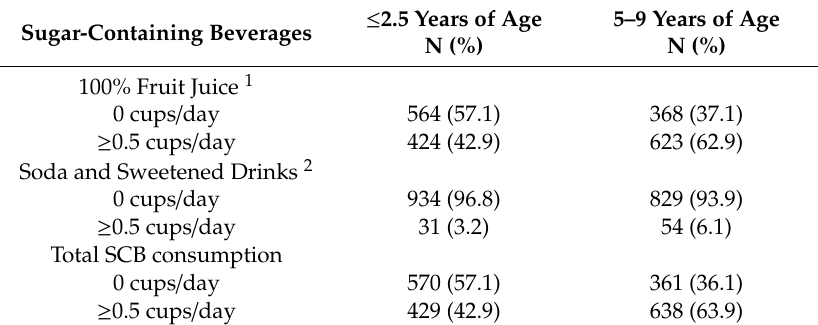
Table 2. Distribution of sugar-containing beverage consumption in children at ≤ 2.5 years of age and 5–9 years of age among children in TARGet Kids! in Ontario, Canada ( n =